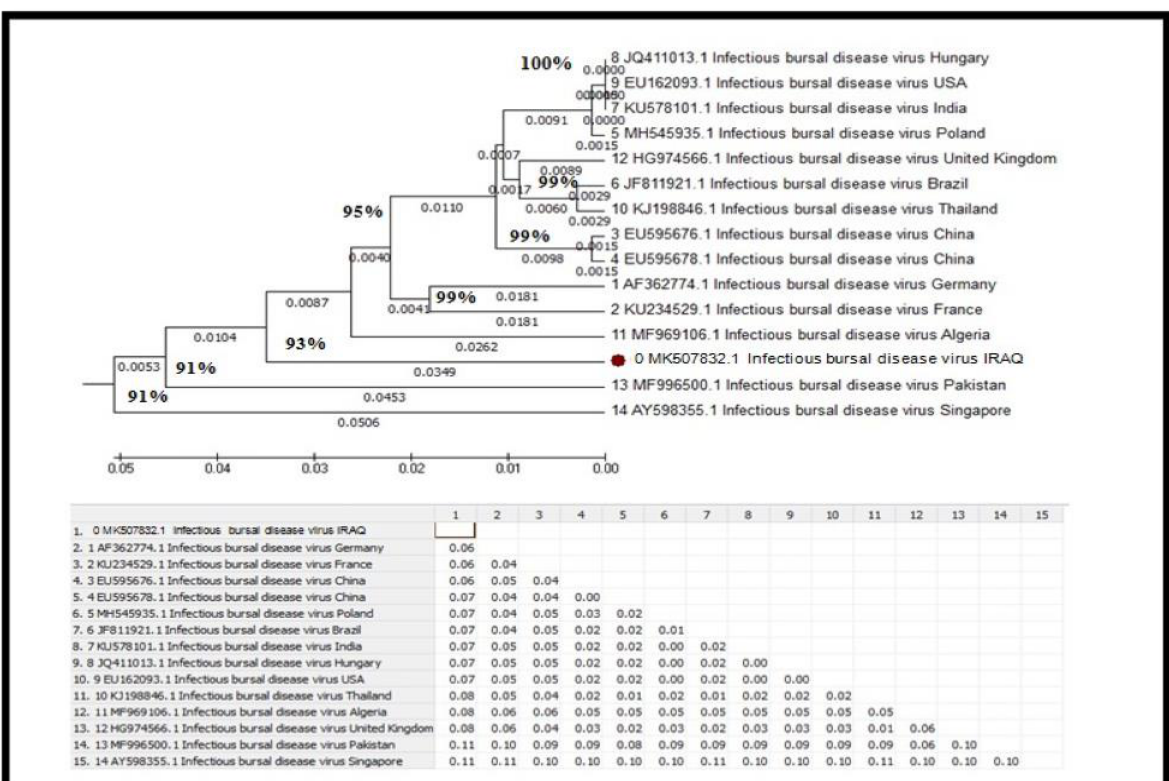
Figure 6. Phylogenetic tree VP1 gene of an Iraqi isolate submitted to NCBI under the accession number